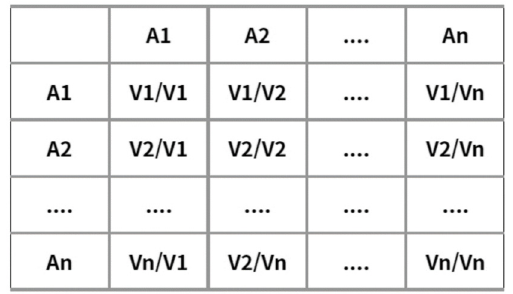
Figure 1. Paired comparison value arrangement table.